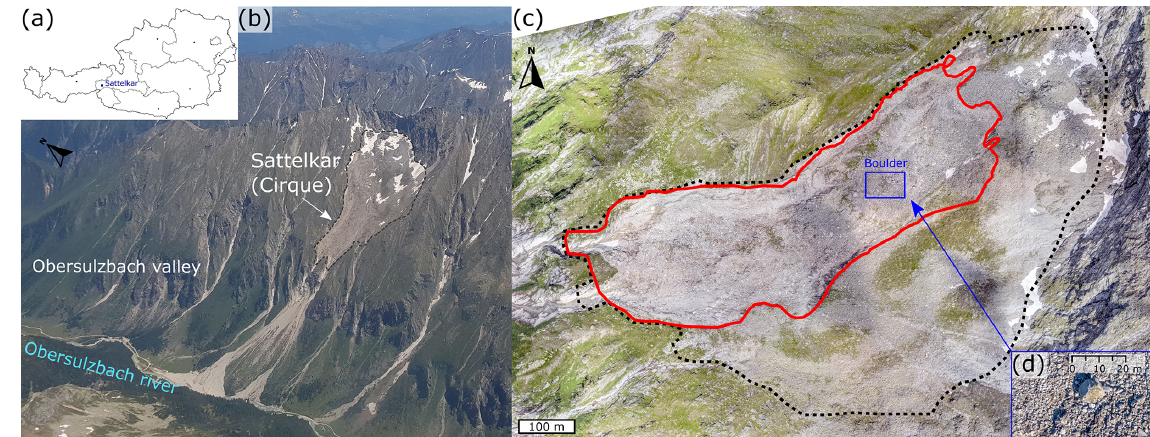
Figure 2. In August 2014, heavy ongoing precipitation triggered massive debris flow activity of 170000m 3 in volume, of which approx- imately 70000m 3 derived from the catchment above 2000m. A further 100000m 3 was mobilised in the channel within the cone. The consequence was that the river Obersulzbach was blocked, leading to a general flooding situation in the catchment and resulting in substan- tial destruction in the middle and lower reaches (Fig. 3).